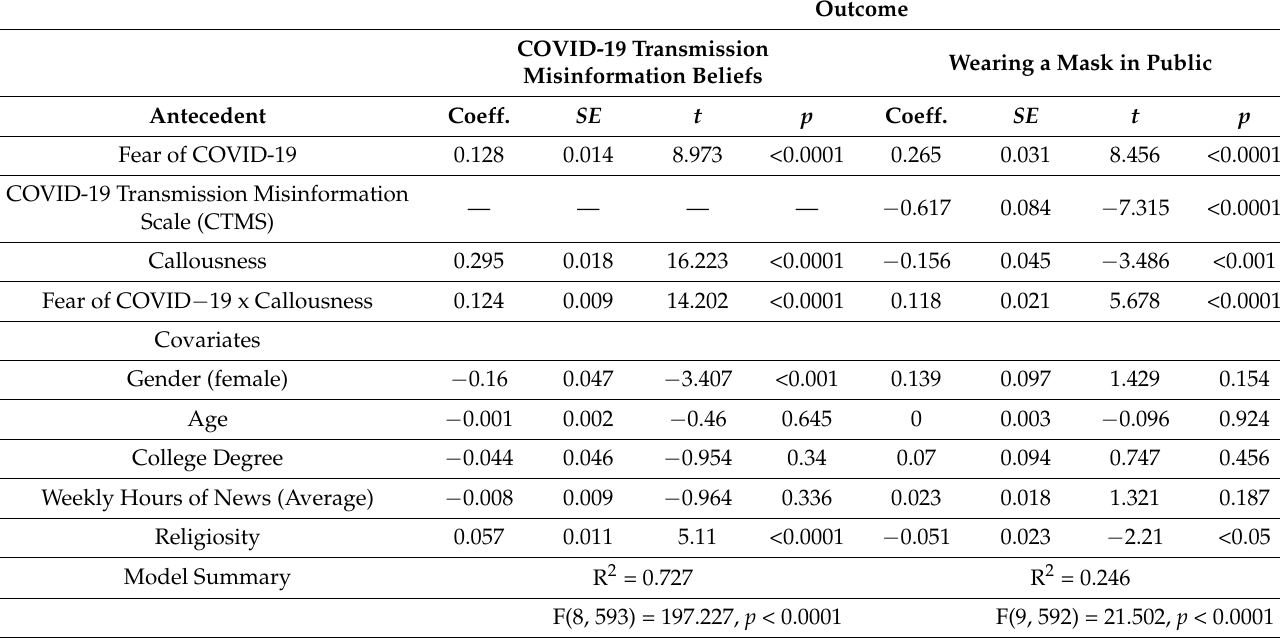
Table 6. Study 4 moderated mediation results of fear of COVID-19 and wearing a mask in public. Outcome COVID-19 Transmission Wearing a Mask in Public Misinformation Beliefs Antecedent